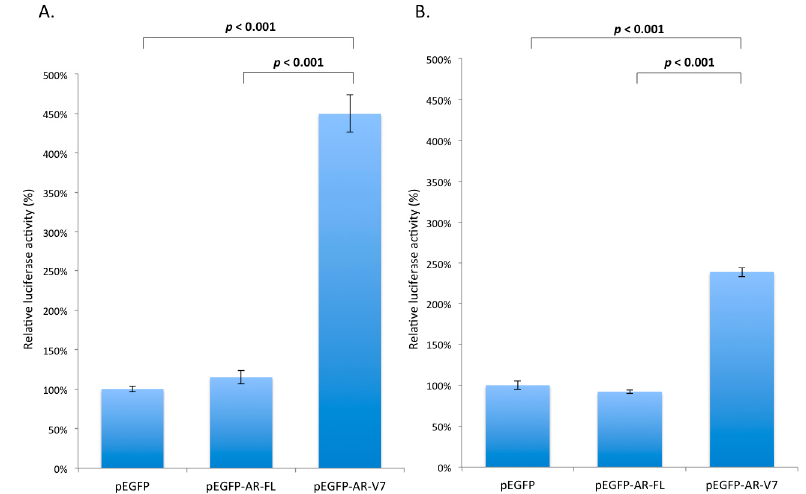
Figure 4. NF- κ B reporter activities in transfected prostate cancer cells. LNCaP ( A ) and 22Rv1 ( B ) cells were transfected with pEGFP, pEGFP-AR-FL, or pEGFP-AR-V7 expression plasmids. Luciferase reporter assay was used to measure NF- κ B activities in those transfected cells. Cells transfected with pEGFP were used as a control. Data are shown as relative luciferase activity (%) ± S.E.